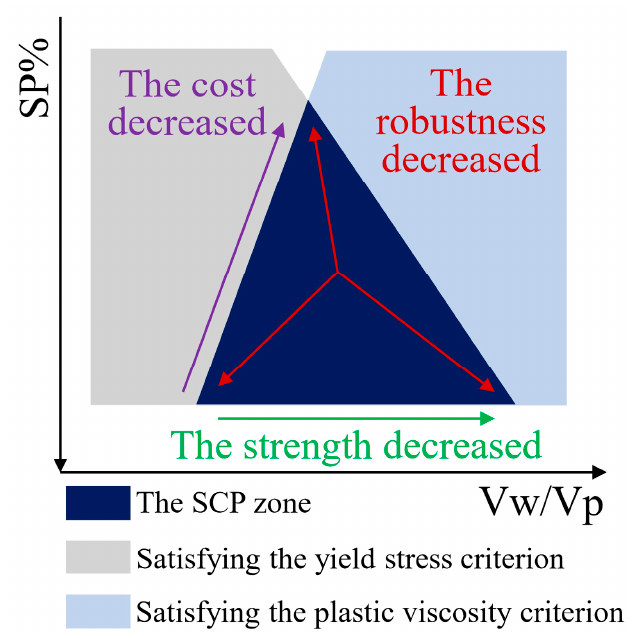
Figure 11. The evaluation trends in the SCP zone.